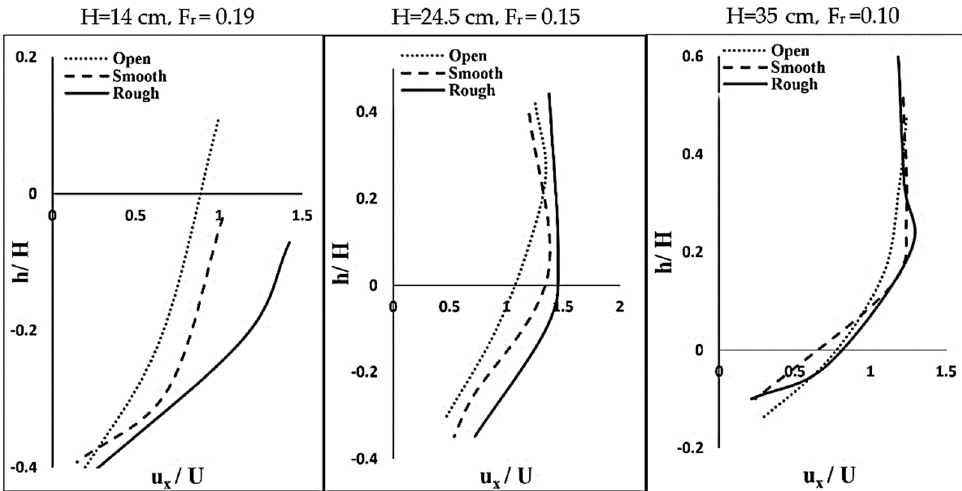
Figure 8. Streamwise velocity profile (u x ) inside and outside the scour holes under different surface cover conditions for the dike orientation angle of 45° for different water depths. ADV measurements subject to +/- 0.25 cm/s error.